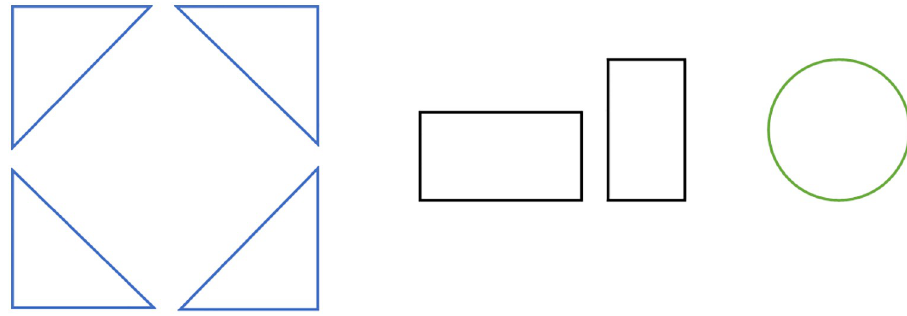
Fig 2. Rotation rules. In this paper, triangular parts are set to have four layout orientations, rectangular parts have two layout orientations, and circular parts have one layout orientation.